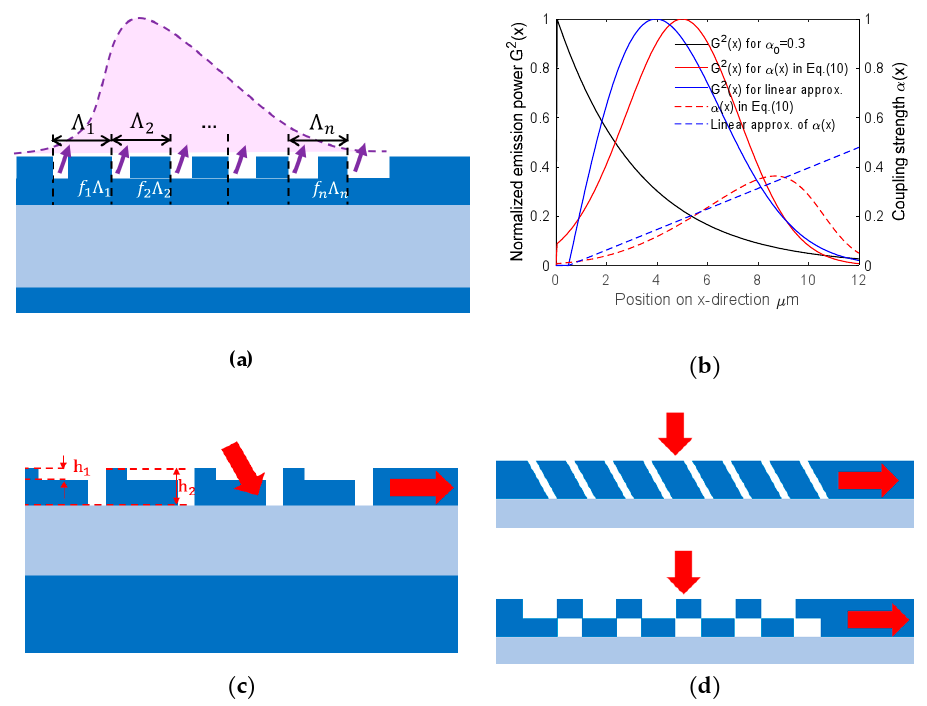
Figure 6. Structural innovations on GC: ( a ) apodized GC with varied duty cycle f n or period Λ n for di ff erent grating teeth; ( b ) theoretical calculation of normalized output power distribution (solid) and coupling strength (dashed) for ideally (red) and linearly (blue) apodized GCs. ( c ) GC with double etch steps; and ( d ) slanted GC (upper) and dual-layer GC